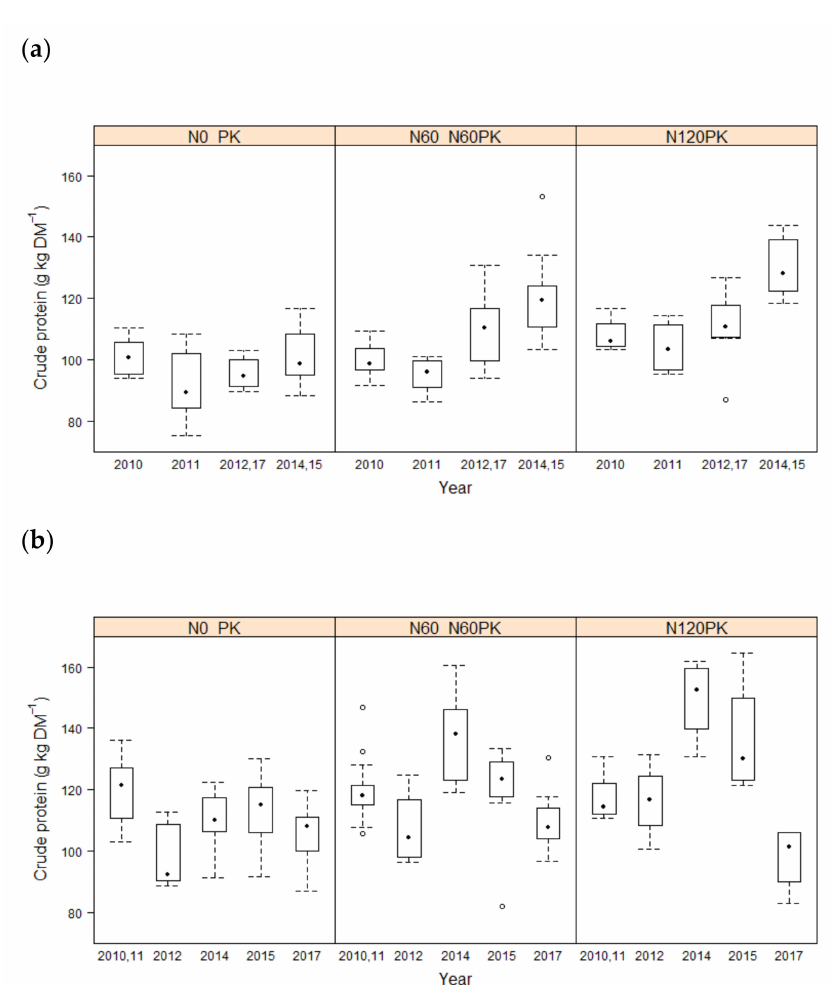
Figure 1. The minimal adequate model for the effect of fertilization treatment and time on the concen- tration of crude protein (g kg DM − 1 ) for the first ( a ) and second ( b ) cuts with different fertilization treatments between 2010 and 2017 (except 2013 and 2016). Level needed for female sheep (70–100 kg):